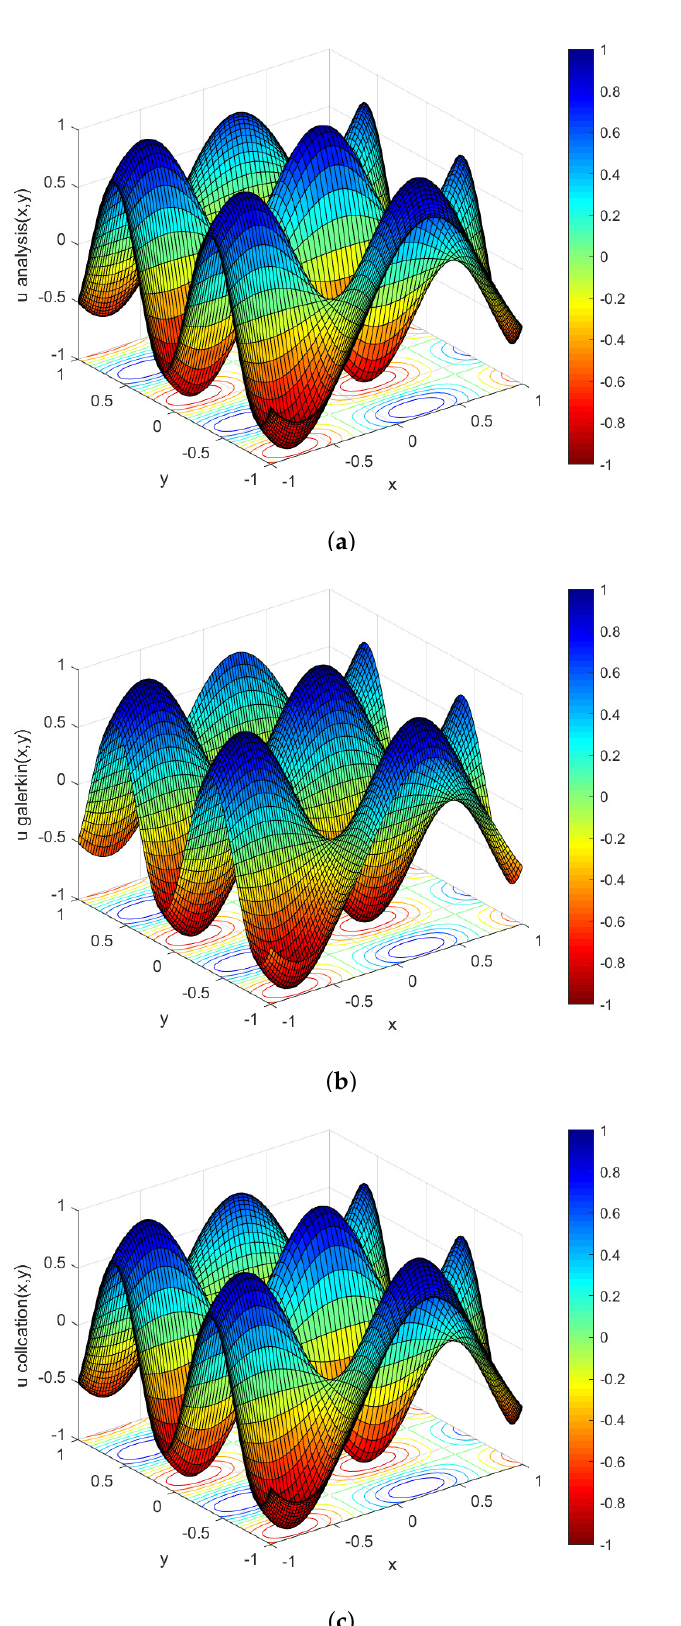
Figure 1. The results of Equation (45) obtained by analytical solution ( a ), Chebyshev–Galerkin spectral method ( b ) and Chebyshev–collocation spectral method ( c